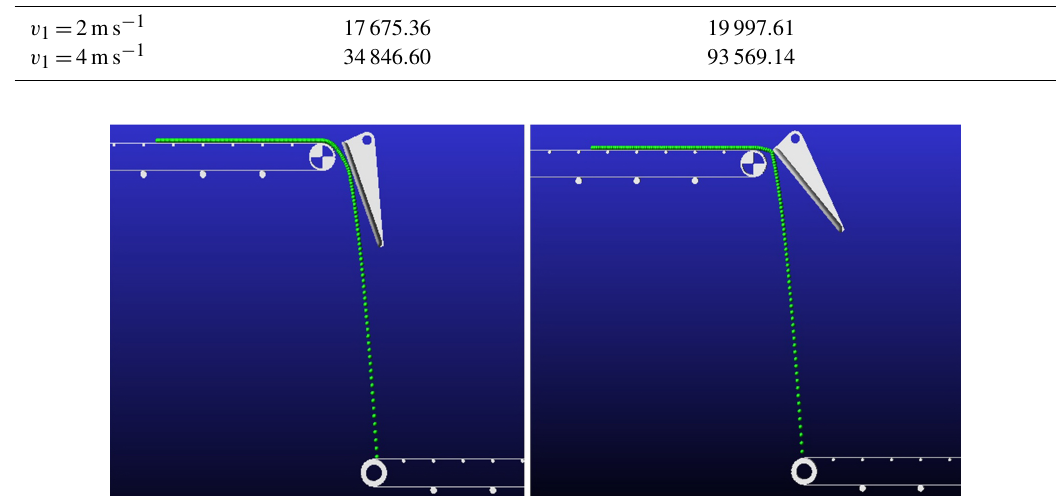
Figure 12. Trajectory of the material particle movement at v 1 = 1ms − 1 , α = 20 ◦ (left), v 1 = 2ms − 1 , α = 40 ◦ (right).